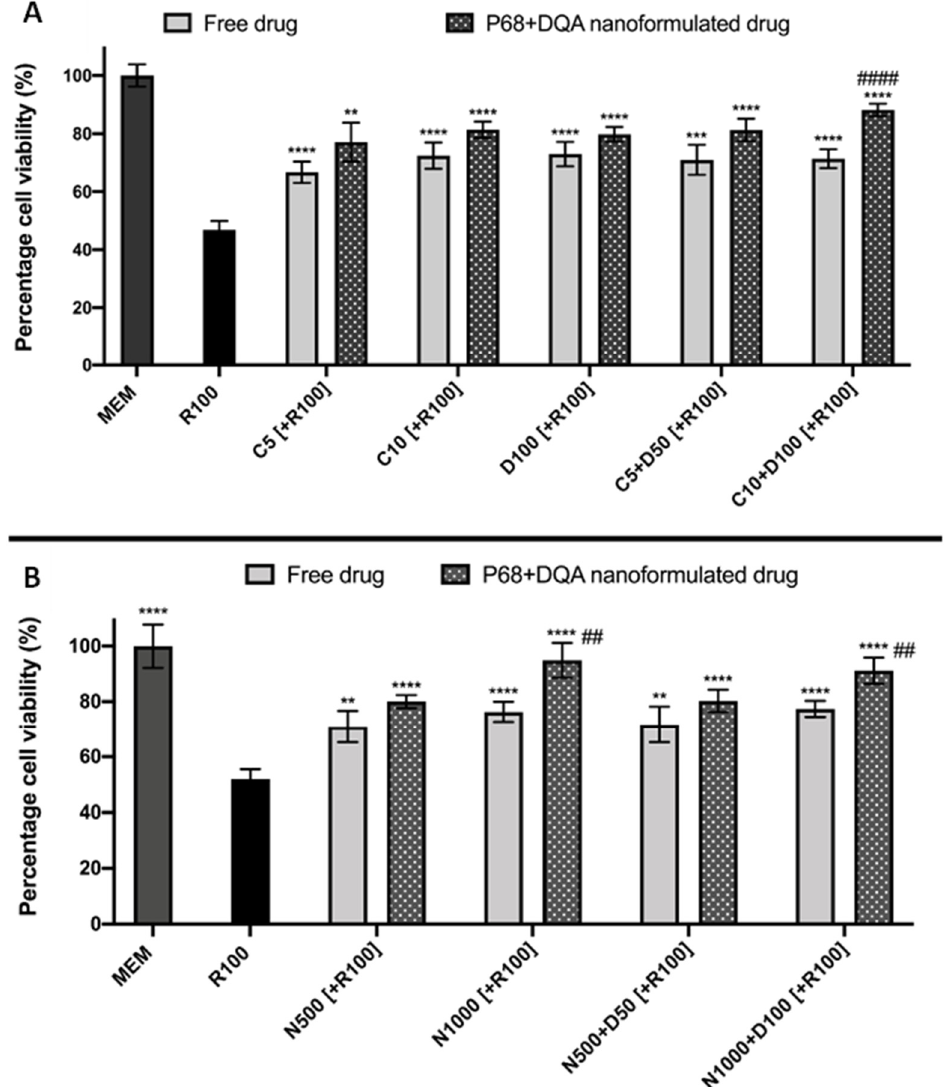
Figure 7. ( A ) SH-SY5Y MTT assay results for free and P68 + DQA preparations of 5 and 10 μ M curcumin, 100 μ M DFO or combined curcumin and DFO (5 or 10 μ M curcumin + 50 or 100 μ M DFO, respectively) following passage across the hCMEC/D3—SH-SY5Y co-culture Transwell ® system. The hCMEC/D3 cells were grown on the insert and the SH-SY5Y cells were located at the bottom of the basolateral compartment. Treatments were added to the apical compartment of the Transwell ® system and incubated for 3 h, the SH-SY5Y cells were then incubated with 100 μ M rotenone for 24 h. These results were compared to rotenone treatment alone. MEM represents the control condition where cells were only treated with media (mean ± S.D., n = 6). ( B ) Corresponding MTT assay results for free and P68 + DQA preparations of 500 and 1000 μ M NAC and combined NAC and DF0 (500 or 1000 μ M NAC + 50 or 100 μ M DFO, respectively) following passage across the hCMEC/D3—SH-SY5Y co-culture Transwell ® system. * represents significance values of control or pre-treatment conditions compared to rotenone treatment alone (**** p < 0.0001, *** p < 0.001, ** p < 0.01). # represents significance values of nanoformulated drug compared to free drug within the same treatment condition (#### p < 0.0001, ## p < 0.01).